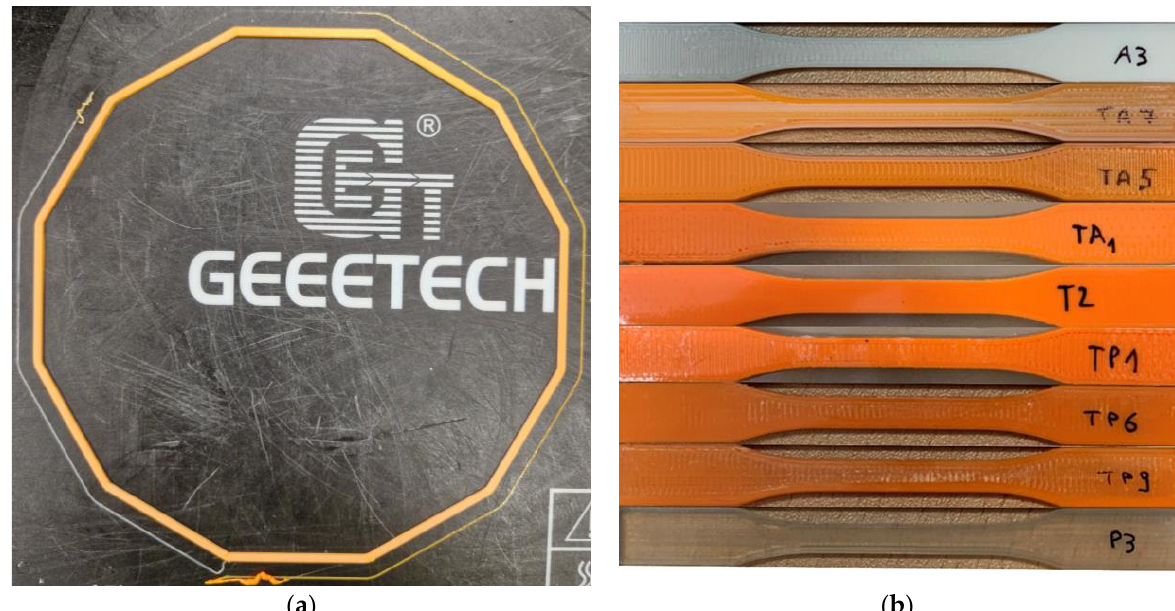
Figure 8. Additively manufactured samples. ( a ) Deposition test (dodecagon shape) ASA-TPU. ( b ) Tensile test samples from top to bottom: 100% ASA; 75% ASA and 25% TPU; 50% ASA and 50% TPU; 25% ASA and 75% TPU; 100% TPU; 25% PLA and 75% TPU; 50% PLA and 50% TPU; 75% PLA and 25% TPU; 100% PLA.